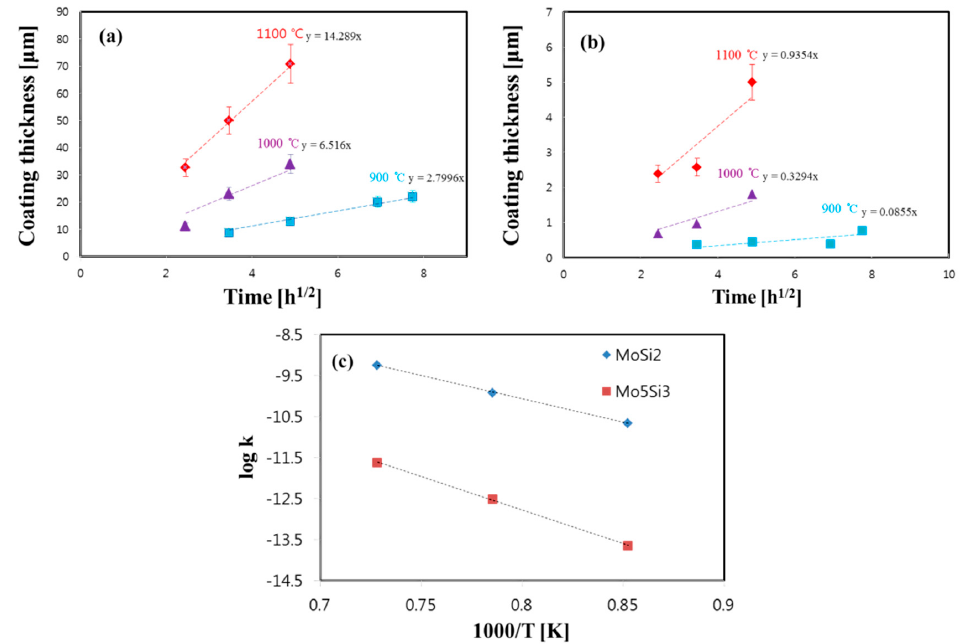
Figure 4. Growth kinetics of ( a ) MoSi 2 ; ( b ) Mo 5 Si 3 layer; and ( c ) kinetic parameters ( k ) with respect to exposure temperature.